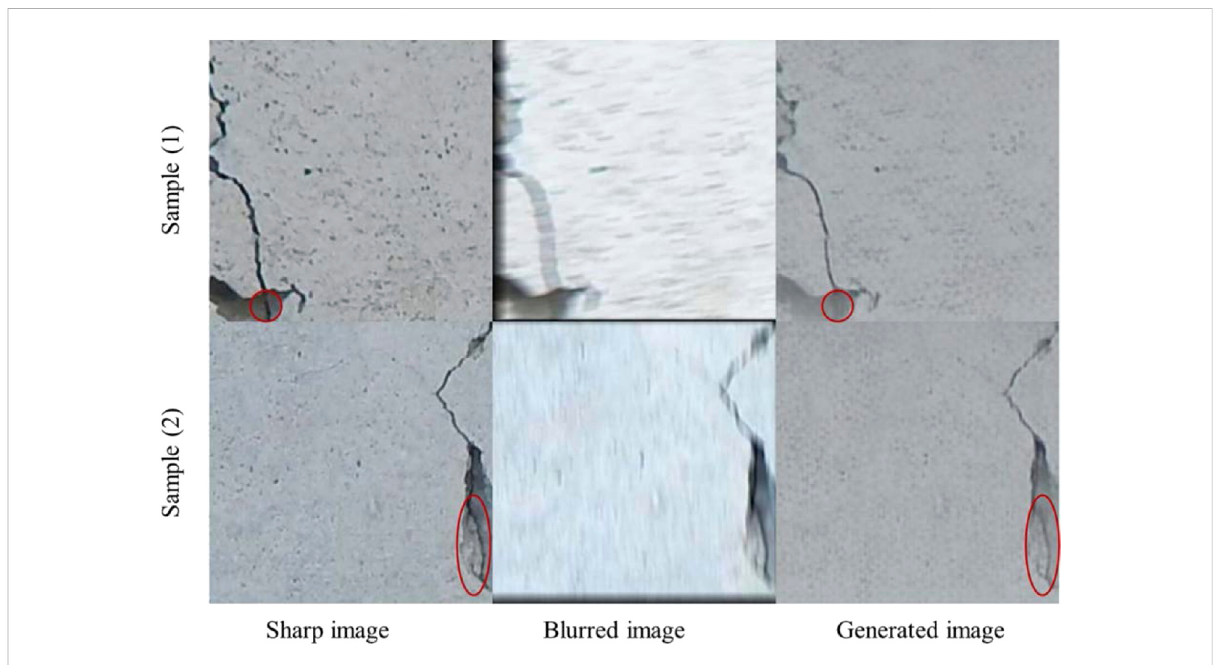
FIGURE 15 Sample results of deblurring on complex backgrounds (Liu et al.,